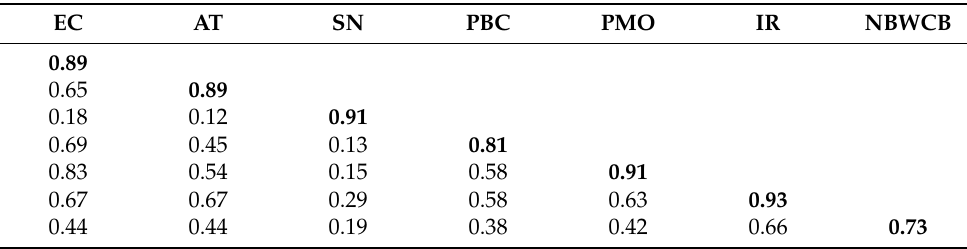
Table 3. Discriminant